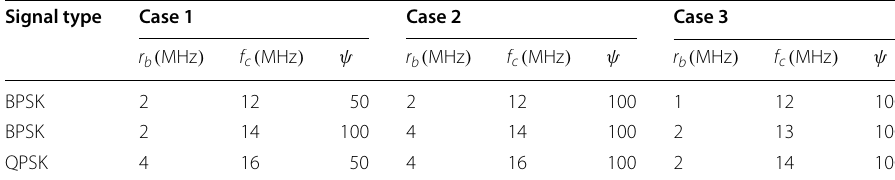
Table 2 The original/source signal setting Signal type